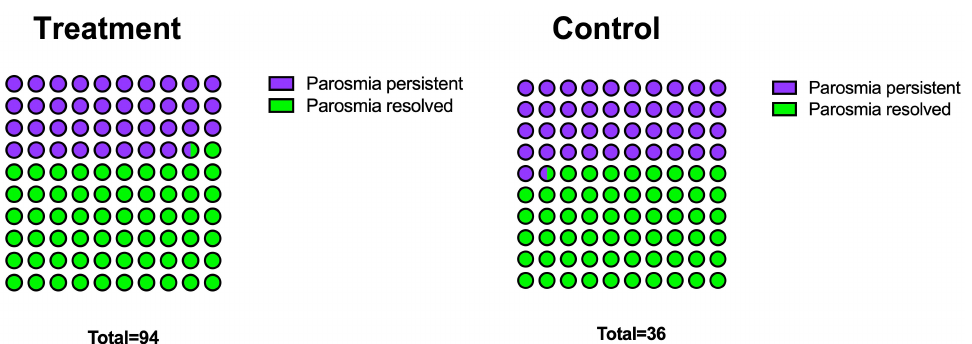
Figure 2. This fi gure shows the comparative results in term of recovery between the treatment group and the control group. ( A ) the graph shows the results obtained in the treatment group; ( B ) the fi gure illustrates the results in the control group.